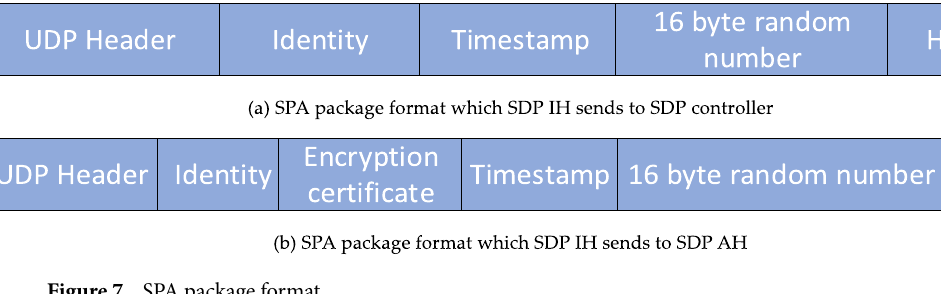
Figure 7. SPA package